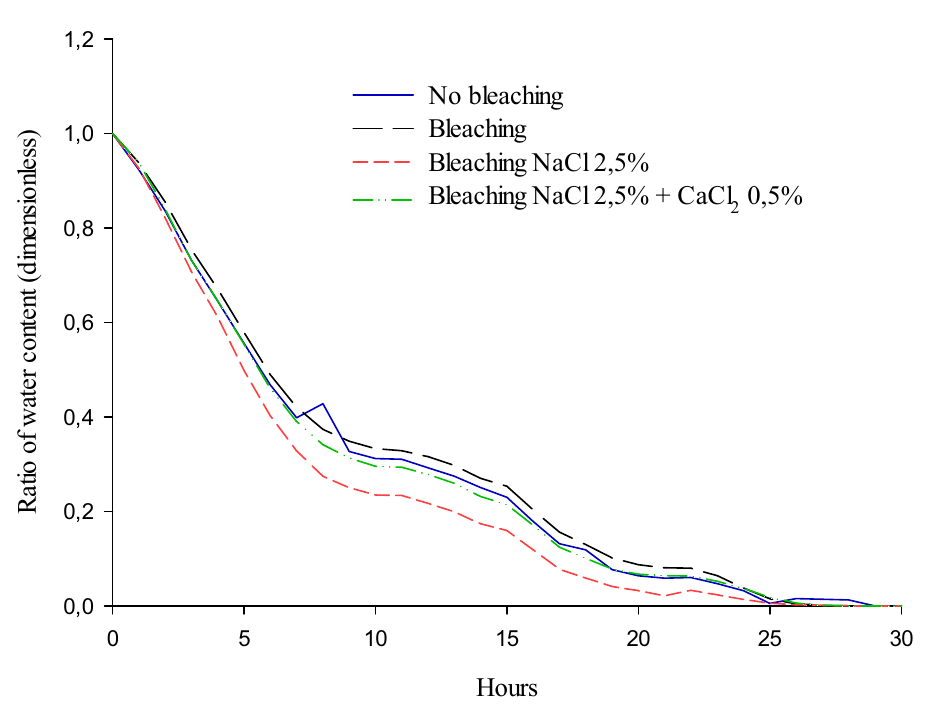
Figure 1. Drying kinetics curves of the tomato ’Carmen’ using handmade solar dryer and direct exposure to solar